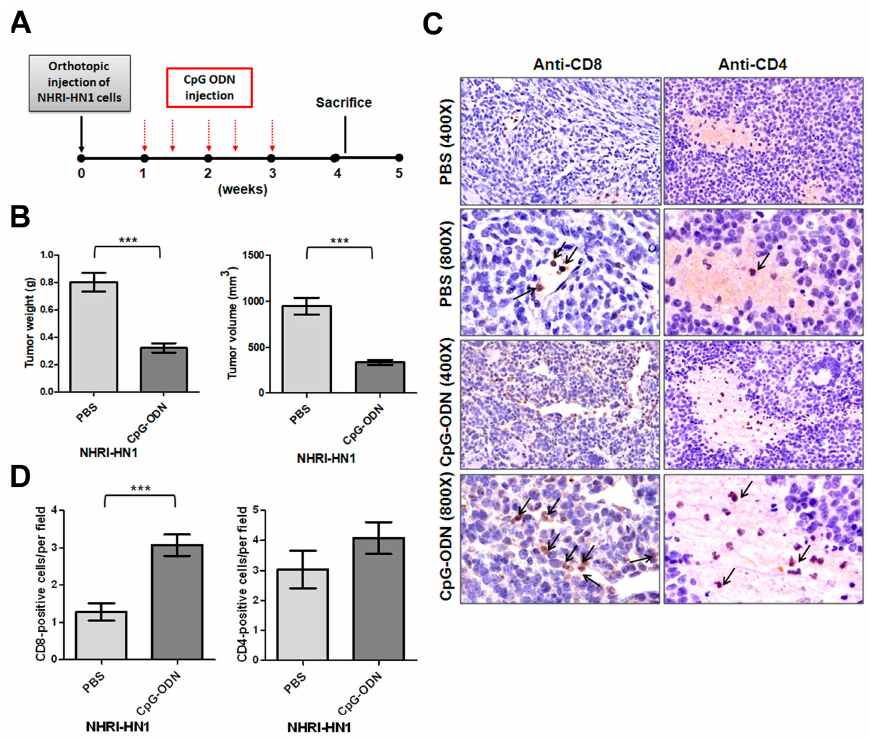
Figure 3. E ff ects of CpG-ODN on tumorigenesis of NHRI-HN1 cells. ( A ) The diagram shows the orthotopic allograft and CpG-ODN (100 µ g / per injection) treatment scheme. ( B ) Quantification of tumor weights (left panel) and volumes (right panel) in the syngeneic mice orthotopically injected